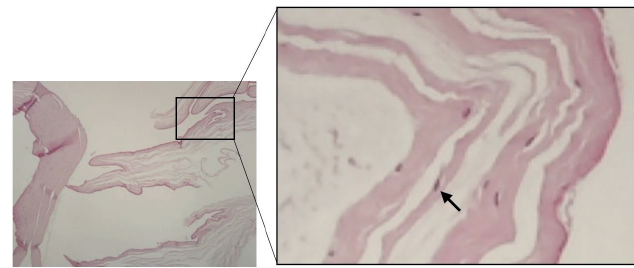
Figure 4 – Amniotic fragment represented by fibrous tissue containing fusiform cells without atypia (Black arrow in the